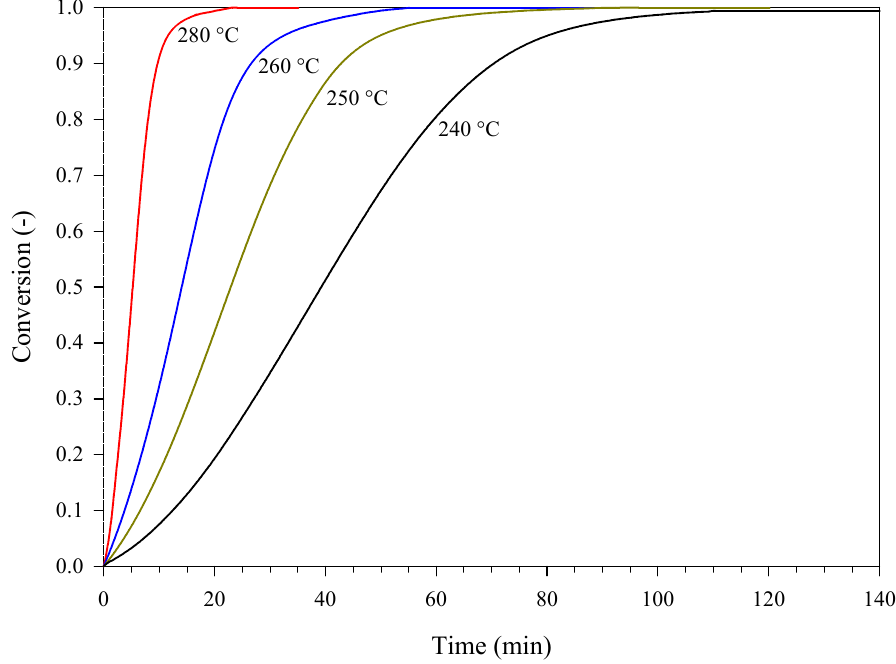
Figure 4. Conversion curves corresponding to specific heat power curves (mean curves) collected during a set of isothermal DSC experiments carried out on samples of PA at different temperatures.